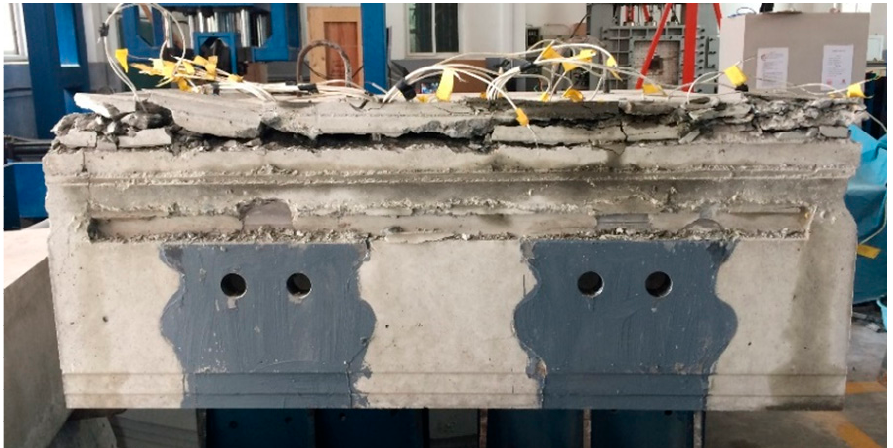
Figure 19. Joint section after testing (Type-A).